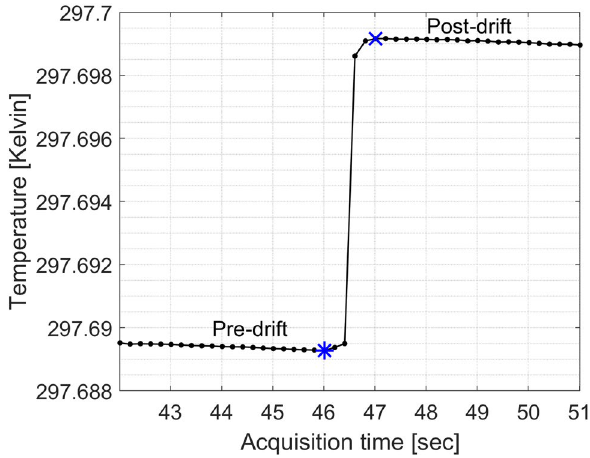
Figure 1. Measured temperature in Kelvin using the NPL PSPC for a FLASH irradiation. The symbols in blue mark approximately the start (*) and end (x) of irradiation as well as the end and start of the pre- and post- irradiation temperature drift curves,